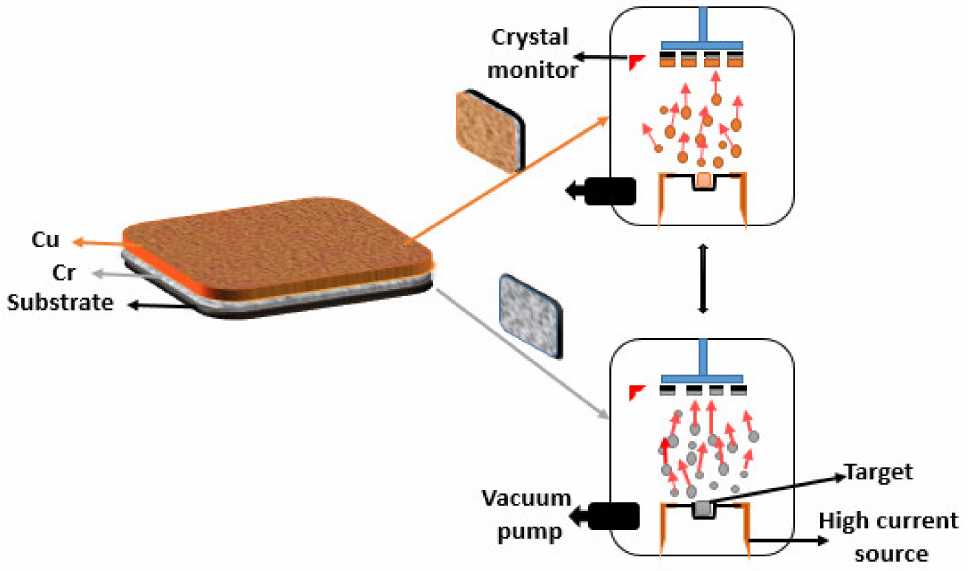
Figure 1. Schematic of Cu/Cr thin film formation by TED